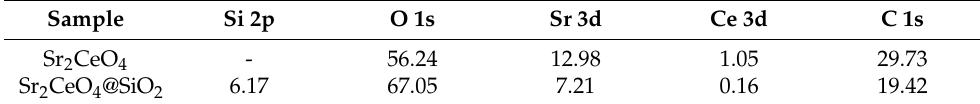
Table 1. The chemical composition of the samples obtained by XPS method in at